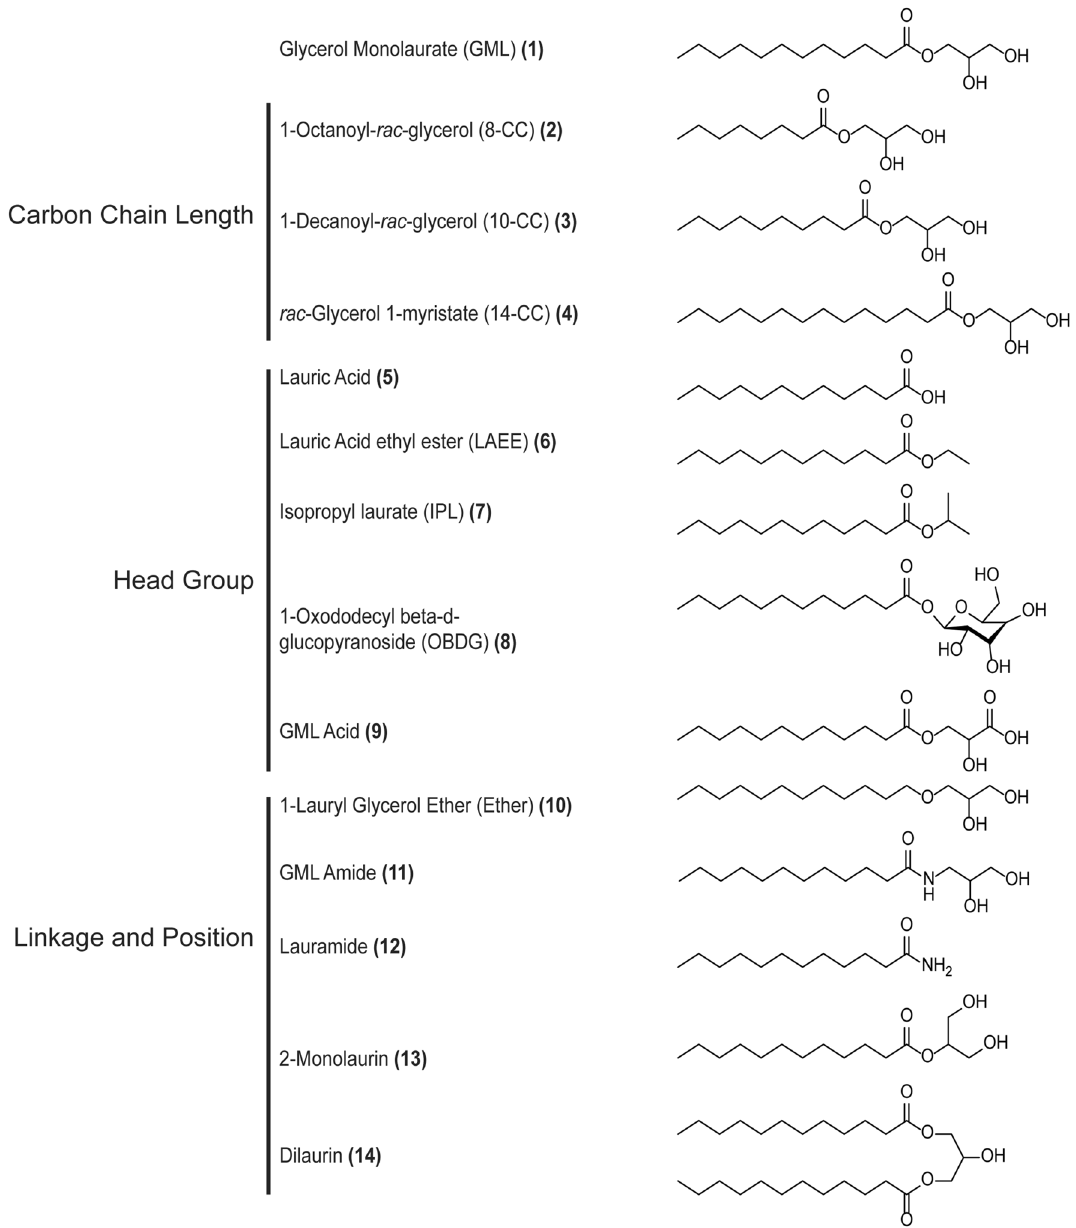
Figure 1. GML analogs used in this study. Structures of compounds used in this study. Analogs varied in chain length, head group, linkage, and